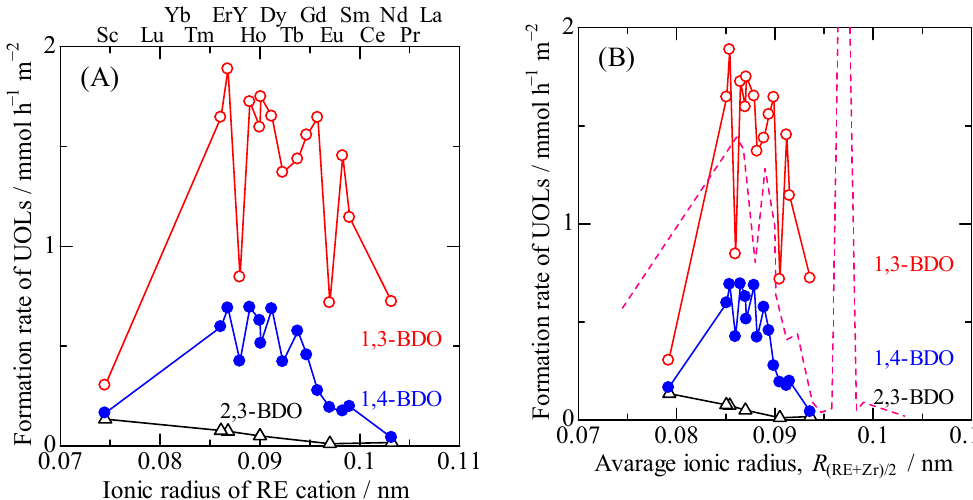
Figure 10. Changes in the formation rate of unsaturated alcohols (UOLs) in the dehydration of BDOs over REZrO catalysts at 325 °C with ionic radius of rare earth cation ( A ) and average ionic radius between Zr 4+ and rare earth cation, R (RE+Zr)/2 ( B ). A dotted line in Figure 10B indicates the formation rate in the dehydration of 1,3-BDO over pure rare earth oxide with ionic radius of rare earth cation, reported in Ref.